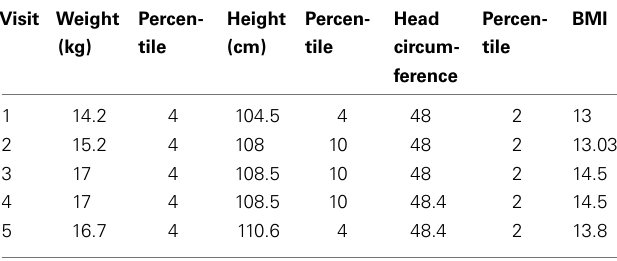
Table 1 | Growth parameters during first cycle of treatment .